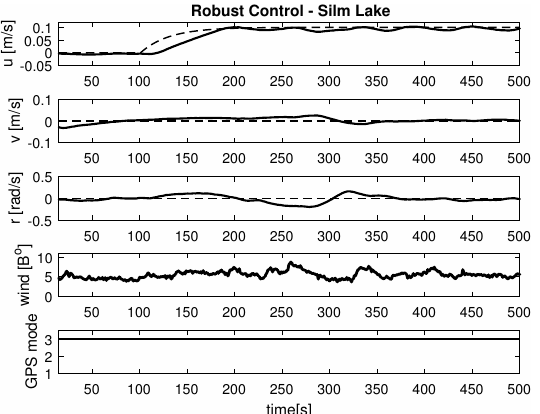
Figure 10. Ahead maneuver with longitudinal velocity u = 0.1 [m/s], v = 0 [m/s], r = 0 [rad/s], wind [ B o ] and GPS mode [-], maneuver duration 500